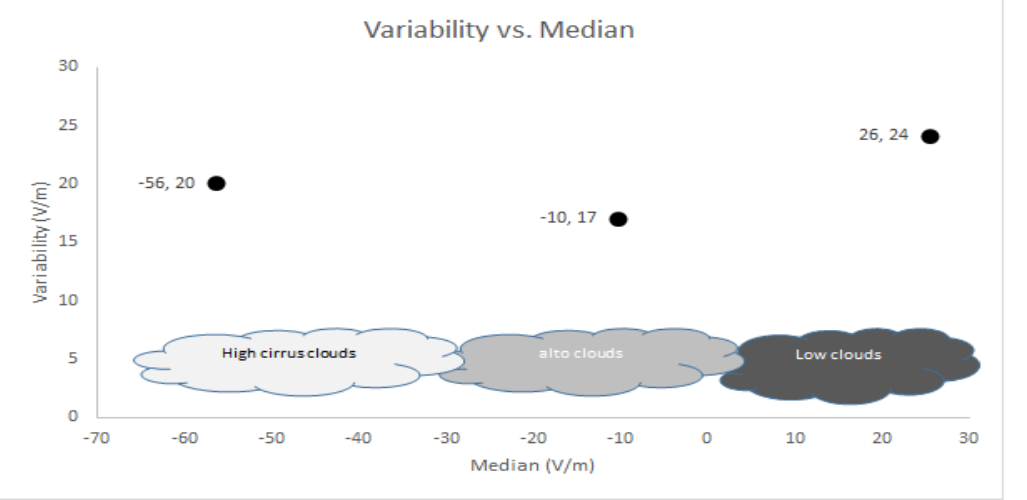
Figure 3. The variability of PG for different types of clouds at Mitzpe Ramon. Variability is expressed in terms of the Inter-Quartile Range and is scaled to one standard deviation for a normal distribution.